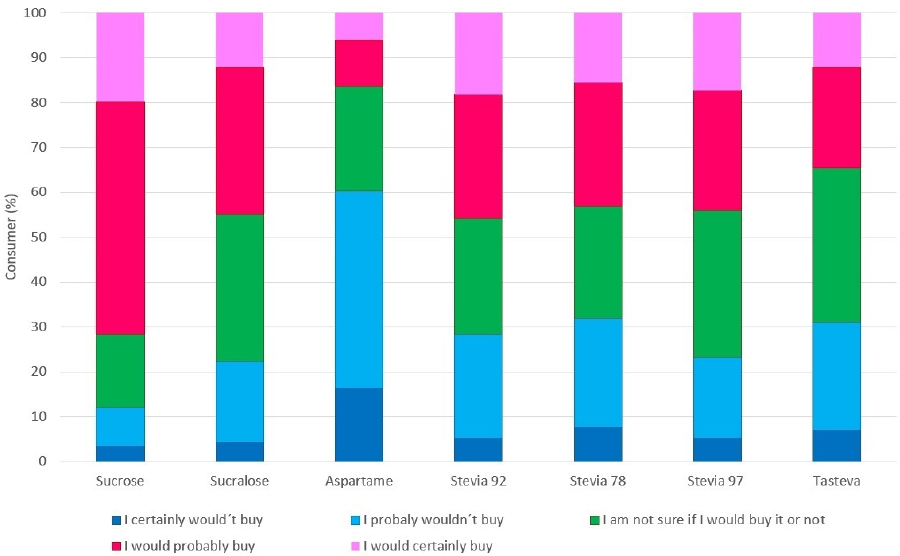
Figure 3. Histogram of purchase intention for blackberry nectar samples.